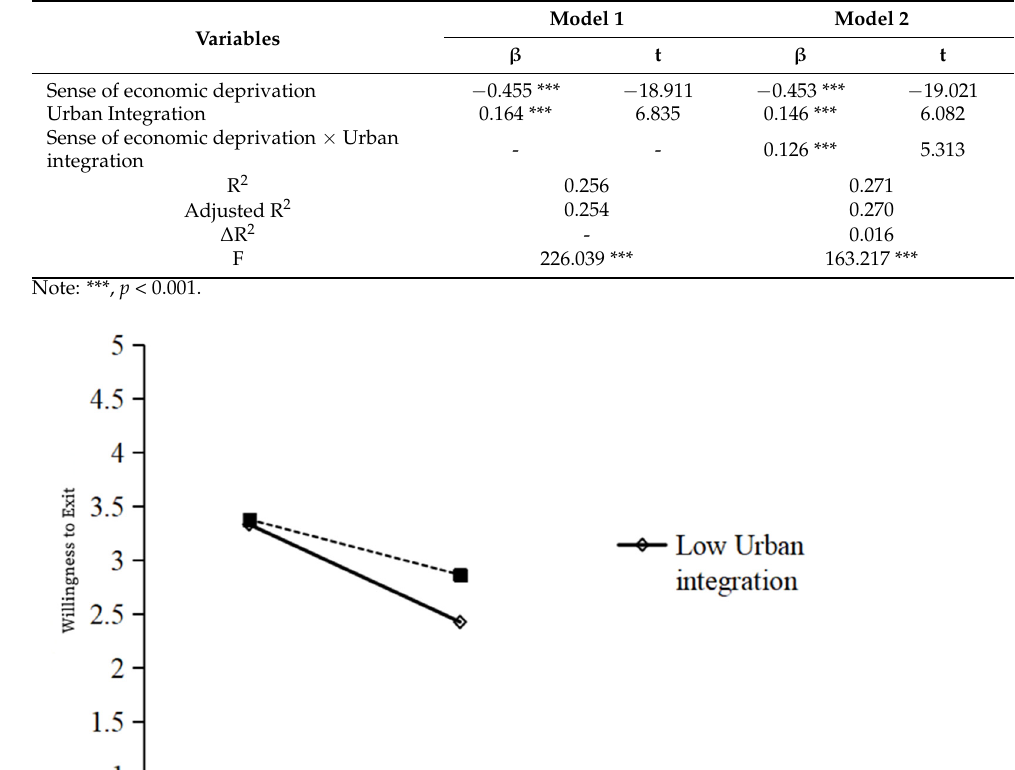
Table 13. The moderating effect of urban integration on the relationship between economic depriva- tion and willingness to withdraw.